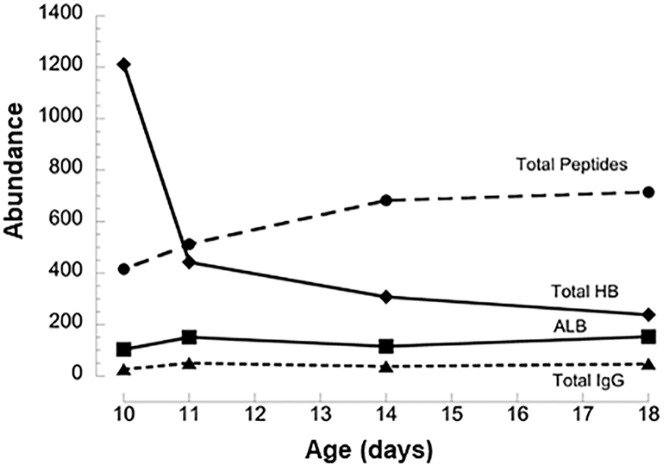
Time course for TA levels of total peptides, total hemoglobin, albumin and total IgG.Example of one infant with TA samples collected between 10 and 18 d postnatal age, showing decreases over time in hemoglobin, but not other major plasma proteins. Values are AIx108 except for total peptide.